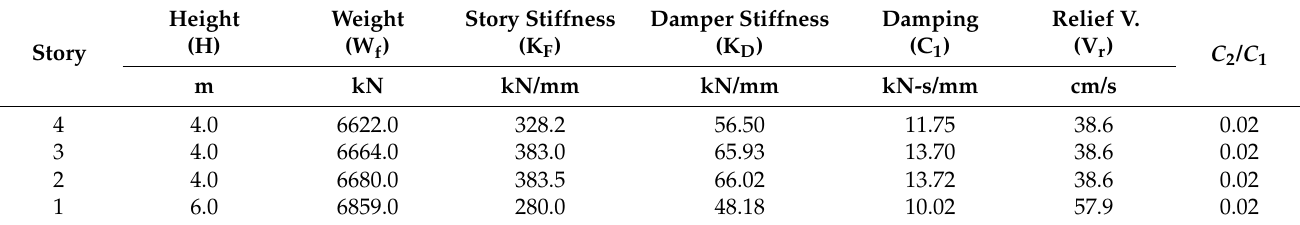
Table 5. Technical parameters of oil dampers for 4-story